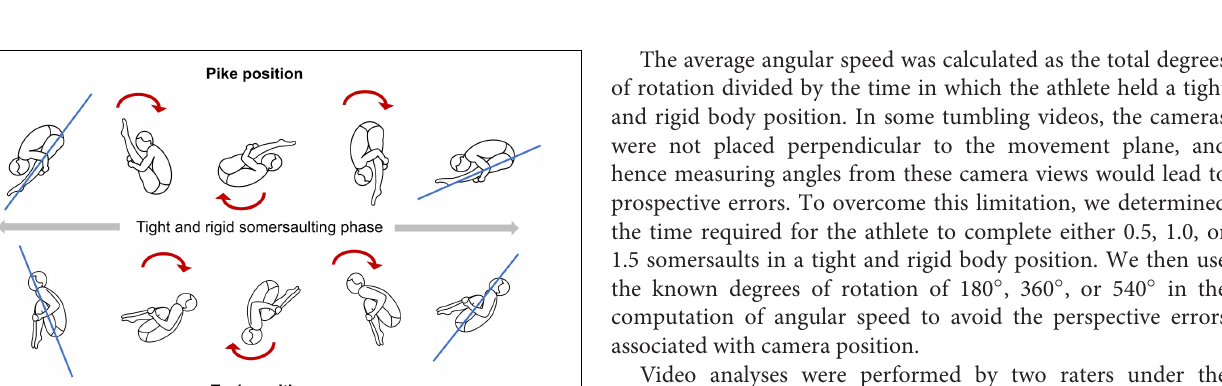
FIGURE 1 | An example of measurement of flight time in (A) diving and (B) gymnastics. The start of flight time is denoted by the circle, while the end of flight time is denoted by the rectangle.